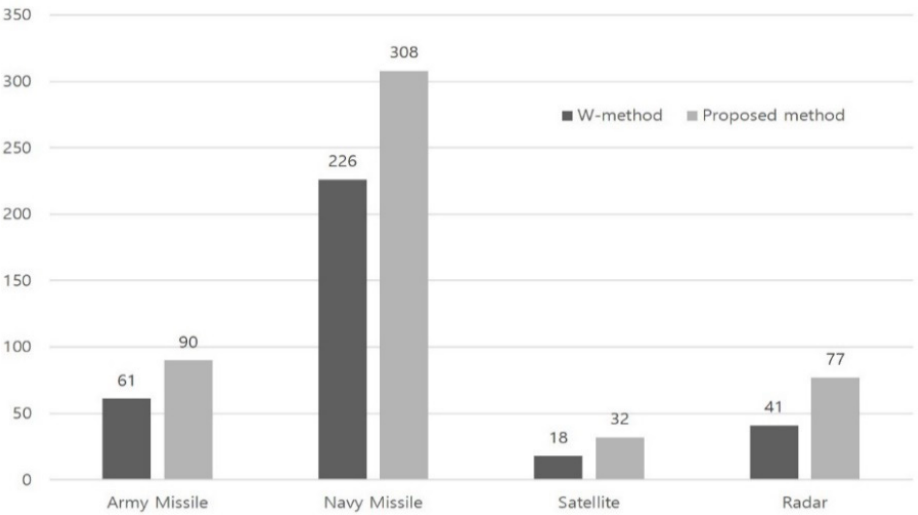
Figure 13. Total testing Length of case studies.